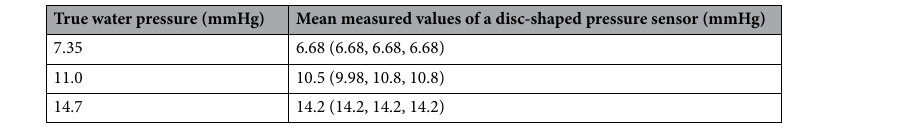
Table 1. Verification of the pressure measurement in the gel with a disc-shaped pressure sensor (n = 3).